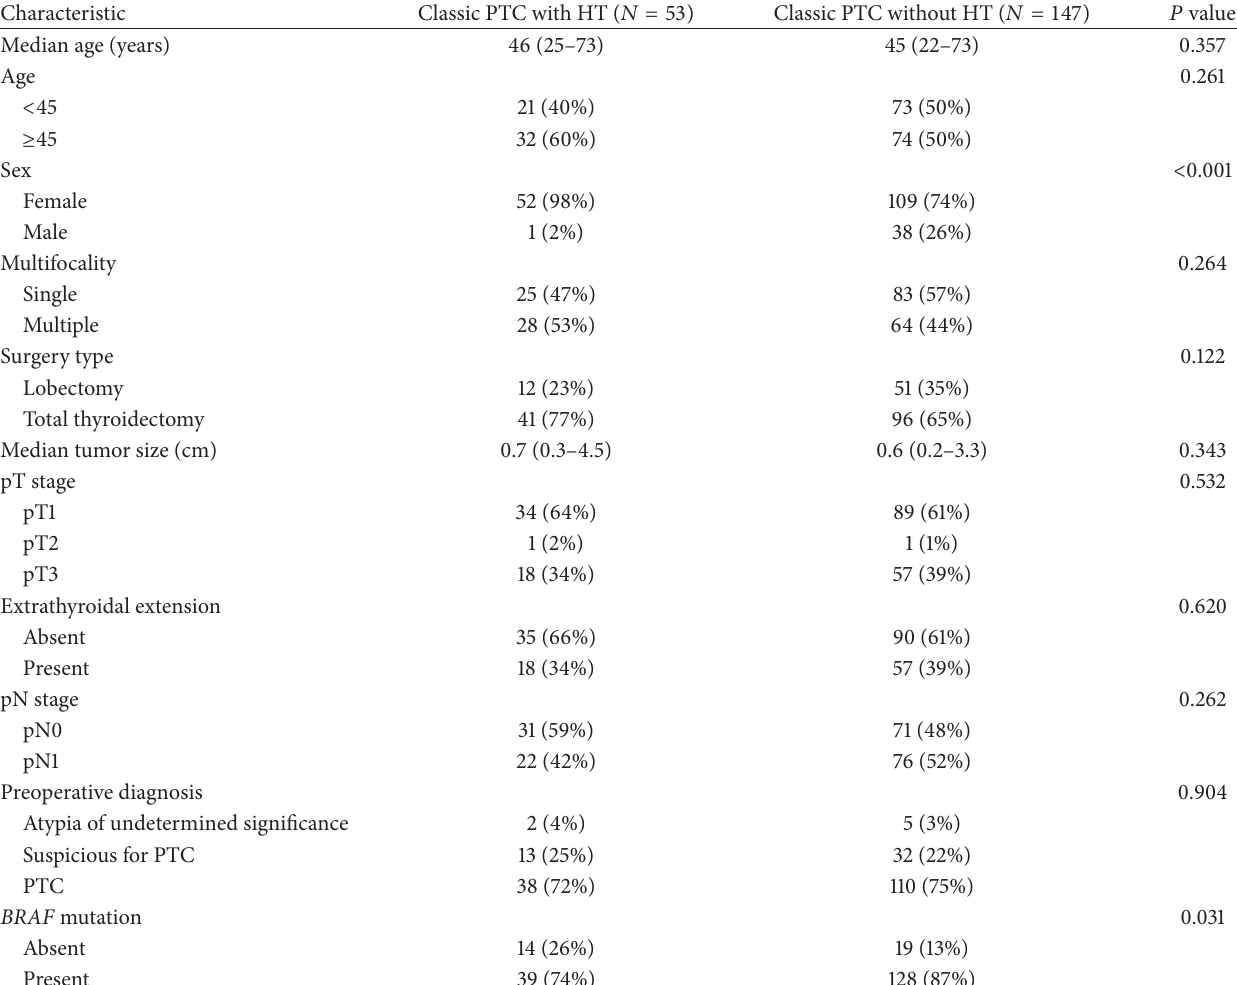
Table 2: Comparison of clinicopathologic characteristics between classic PTC with or without HT.